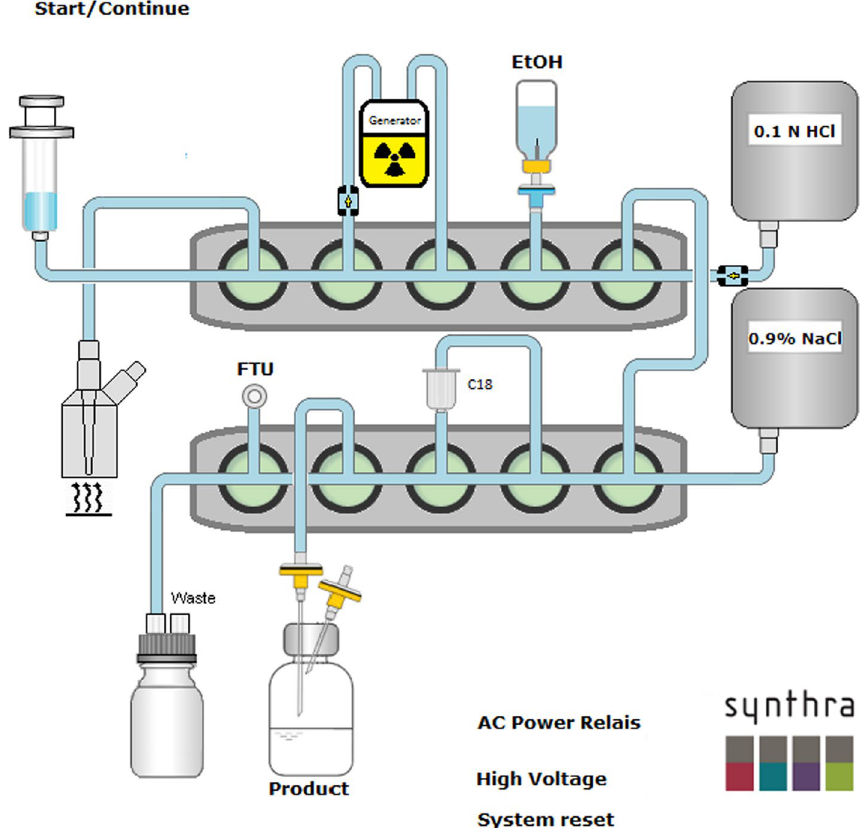
Fig. 3 Scheme of the automated GaSy synthesizer from Synthra for [ 68 Ga]Ga-FAPI-46